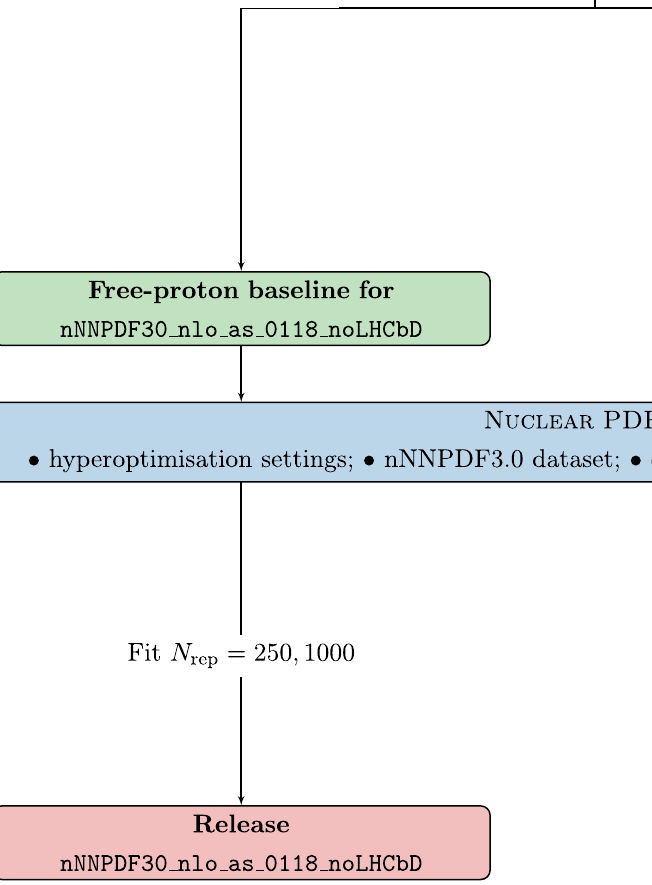
Fig. 4 Schematicrepresentationofthefittingstrategyusedtoconstruct the nNNPDF3.0 determination. The starting point is a dedicated proton globalfitbasedontheNNPDF3.1methodologybutwiththeNNPDF4.0 proton-only dataset. This proton PDF fit is then reweighted with the LHCb D meson production data in pp collisions, which upon unweight- ing results into the proton PDF baseline to be used for nNNPDF3.0 (via